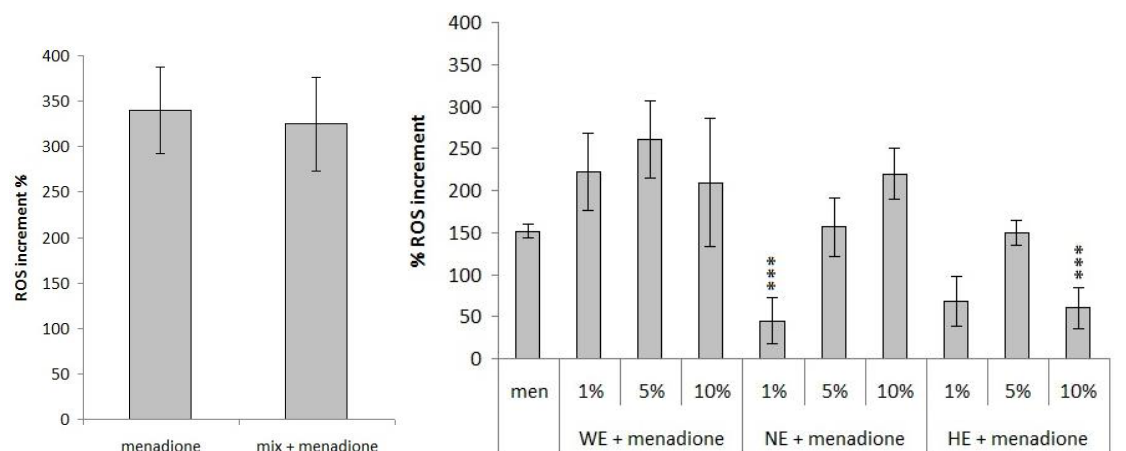
Figure 5. Figure 5. Evaluation of different spinach extract (left) and of single component mix (right) antioxidant ability to counteract menadione (100 µ M) oxidative insult after 24 h of treatment expressed as ROS increment % (*** p <